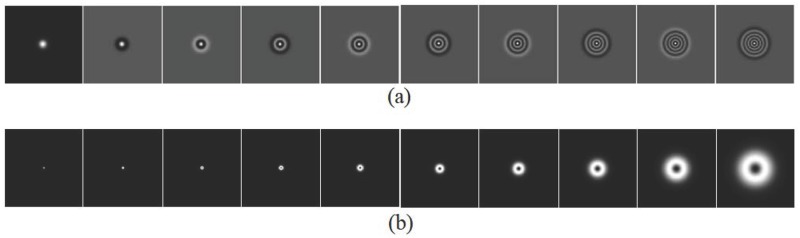
Exampled channels of LG CHO and D-DOG CHO.(a) Exampled 10 number of LG spatial channel images with au = 11 pixels (left: p = 0, right: p = 9). (b) Exampled 10 number of D-DOG frequency channel images (left: i = 1, right: i = 10).